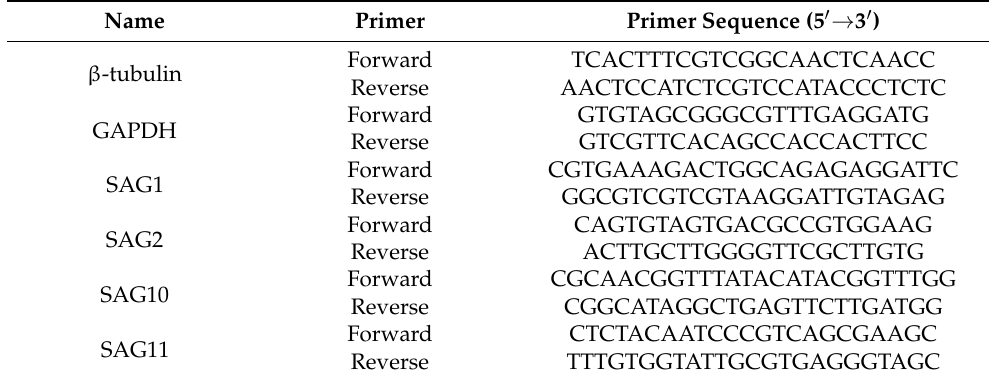
Table 3. The qRT-PCR primers of EmSAGs and internal reference genes Em - β -tubulin, Em -GAPDH.